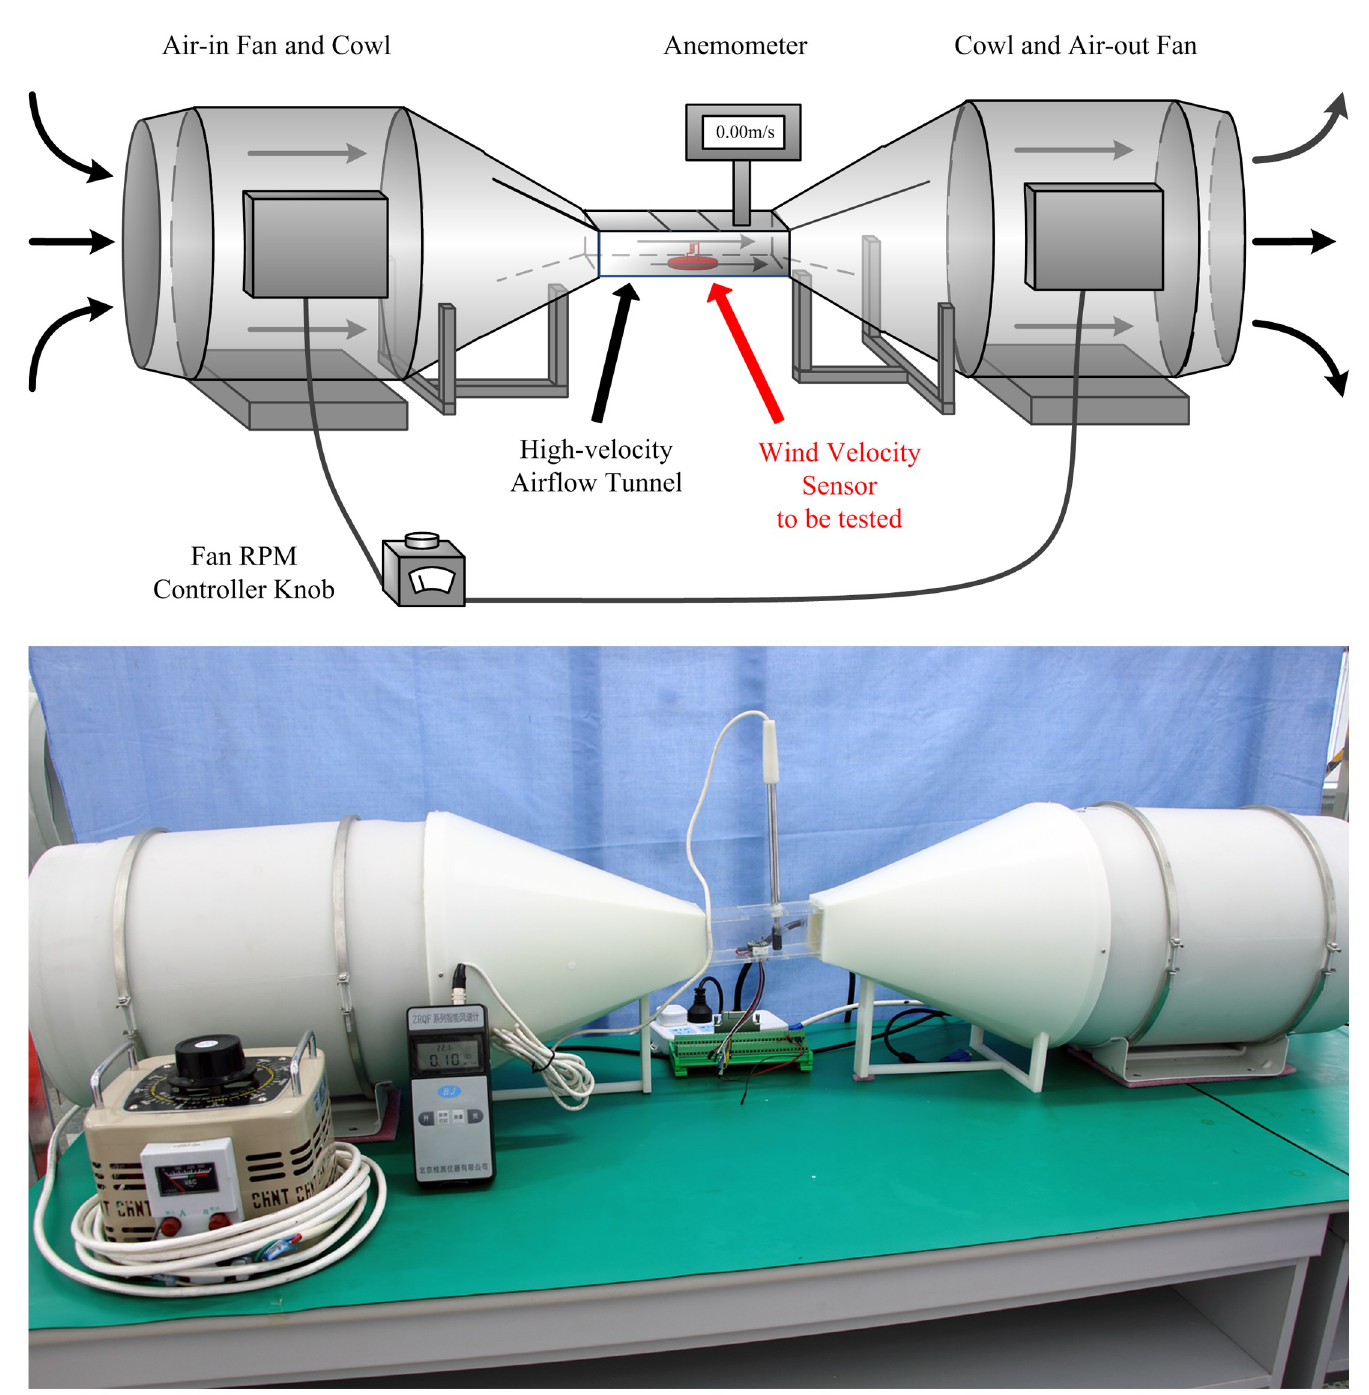
Fig 11. High-velocity airflow system for calibration and testing of wind velocity sensors. (A) Block diagram and (B) image of the high-velocity airflow system.